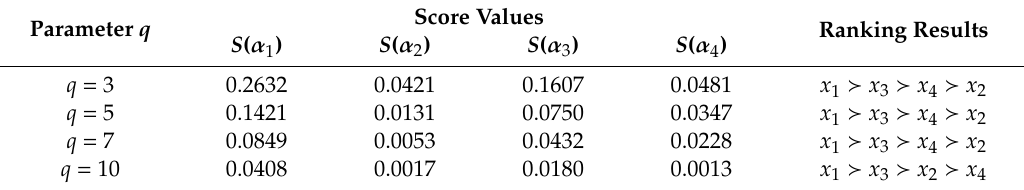
Table6. E ff ectoftheparameter q onthescorevaluesandrankingresultsutilizingthe q -RPDHFPWDMM. Score Parameter q